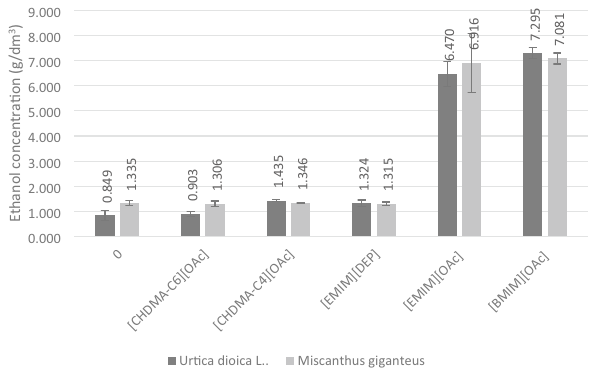
Figure 4. Ethanol content after alcoholic fermentation of Urtica dioica L. and Miscanthus × giganteus samples untreated and treated with ILs.